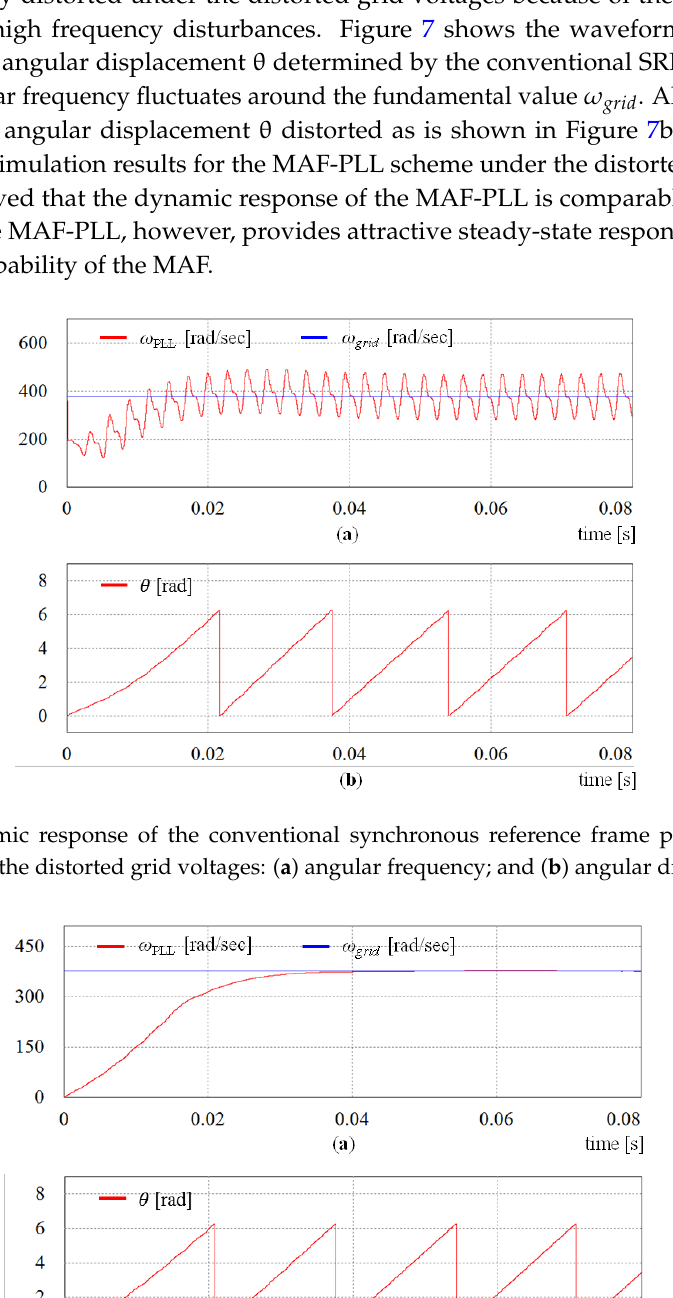
Figure 6. Performance comparison of dynamic responses between the BPF and MAF when DC-quantity of inverter currents is extracted at the synchronous frame under the distorted grid voltages: ( a ) using BPF; and ( b ) using MAF.